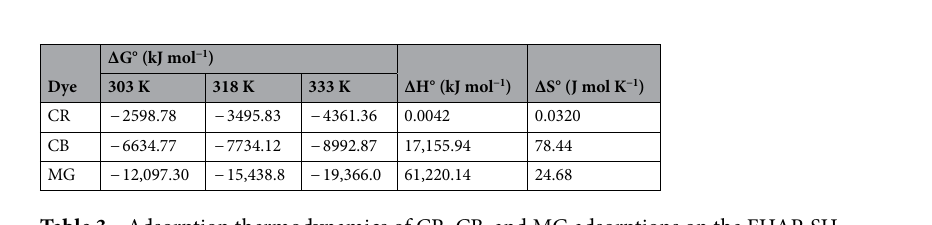
Table 3. Adsorption thermodynamics of CR, CB, and MG adsorptions on the FHAP-SH.